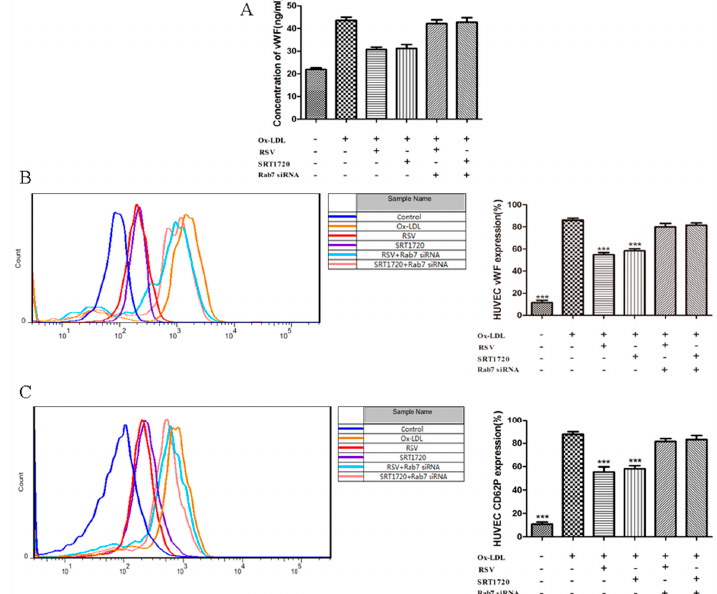
Figure 6. E ff ect of gene silencing Rab7 on the inhibition of vWF and P-selectin secretion by Sirt1 / FoxO1 pathway activation. HUVECs were transfected with Rab7 siRNA for 24 h and incubated with 100 µ g / mL ox-LDL and 10 µ M RSV or 5 µ M SRT1720 for 12 h. The secretion of vWF to extracellular ( A ) was determined by ELISA assay, and the secretion of vWF ( B ) and P-selectin ( C ) to cytomembrane was detected by flow cytometry. Values are presented as the means ± SD (ELISA assay: n = 6, flow cytometry: n = 3). Statistical significance between the ox-LDL treated group and other groups was determined by one-way ANOVA: Compared with the ox-LDL group, *** p < 0.001.